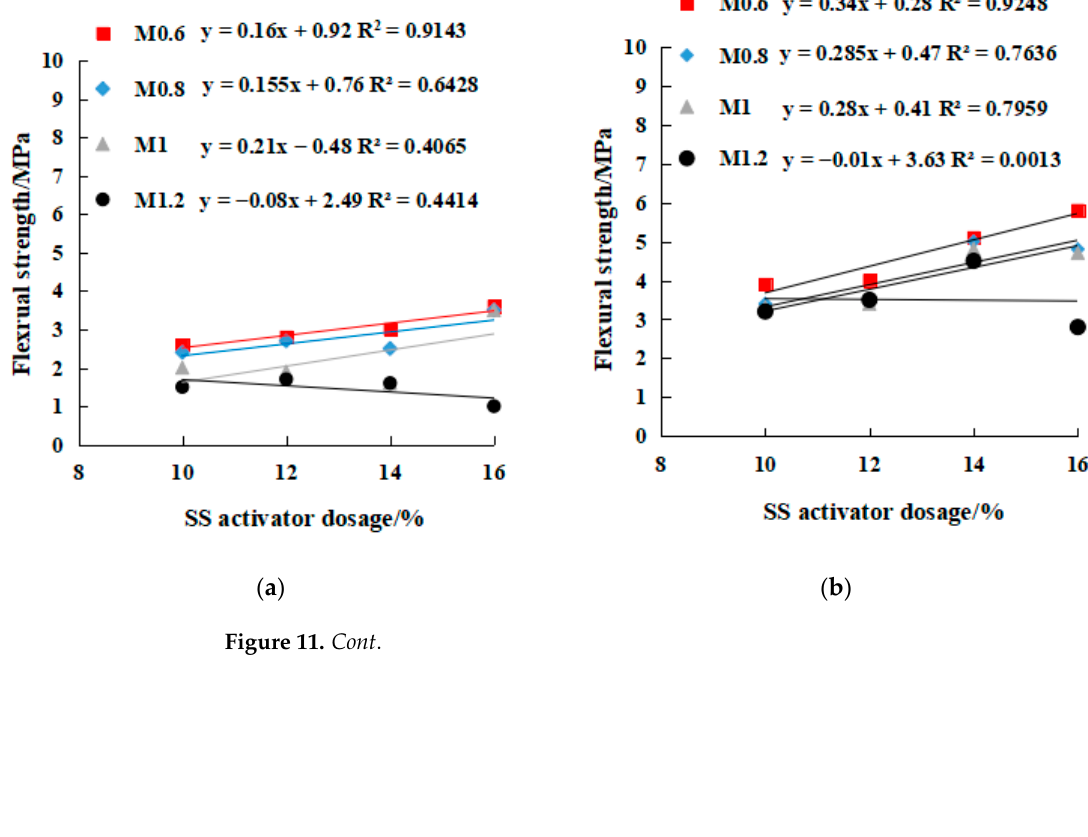
( c ) Figure 11. Relationship between flexural strength and SS activator dosage. ( a ) 3 days, ( b ) 7 days, ( c ) 28 days. y = ax + b, where y is the compressive or flexural strength, MPa. x is SS activator dosage, and 10 ≤ x ≤ 16%. a and b are constants. 3. Characterization The 28-day SH18 and SSG13 samples were selected for mineral and microstructural analyses using XRD, FTIR, SEM, and EDS -microscopic tests. Through these tests, the min- eral composition, functional groups, and microscopic morphology of the two geopoly- mers were compared. 3.1. XRD Tests